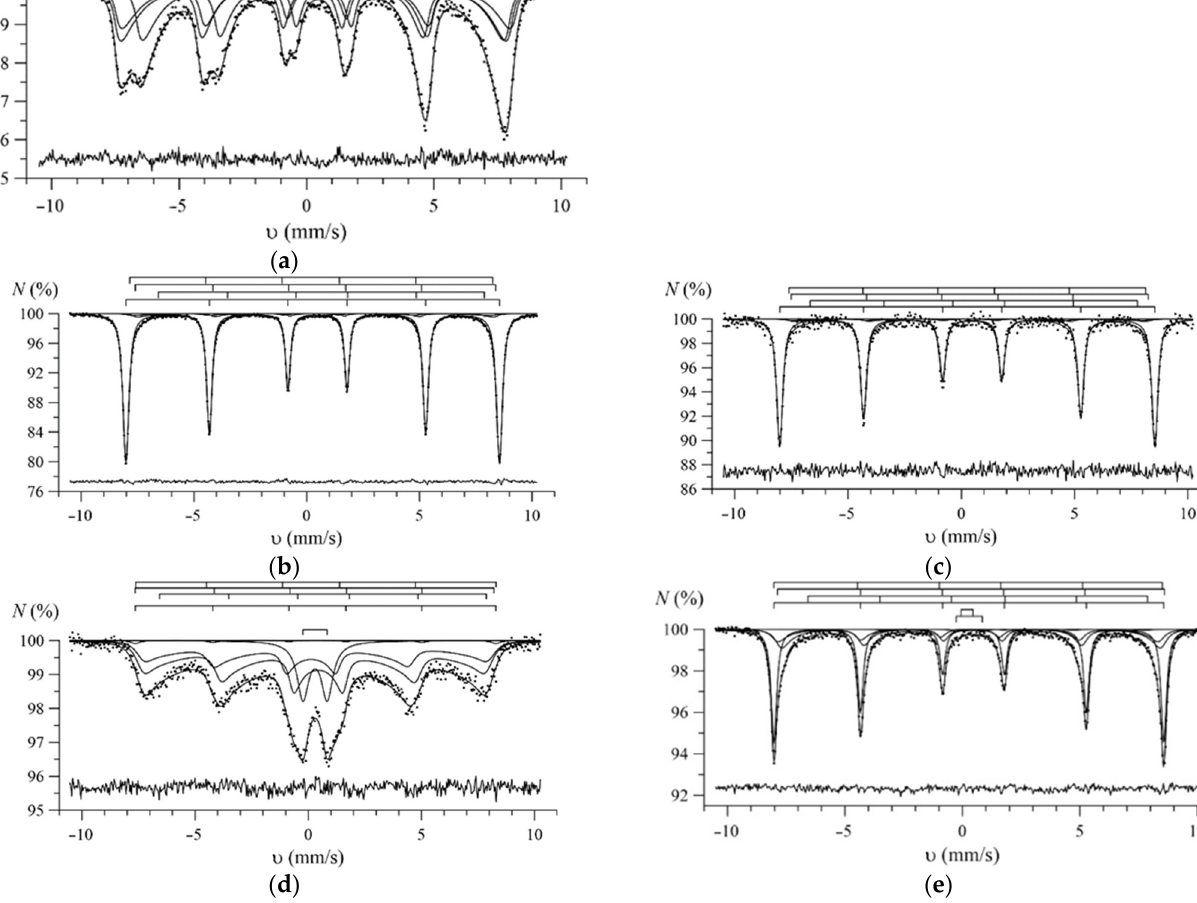
Figure 6. Mössbauer spectra of the studied nanoparticles: ( a ) S0—Fe 3 O 4 (initial), ( b ) S1—Fe 3 O 4 (600 °C), ( c ) S2—Fe 3 O 4 @Au (600 °C), ( d ) S3—Fe 3 O 4 /Gd(NO 3 ) 3 ·6H 2 O (600 °C), ( e ) S4—Fe 3 O 4 /NdFeO 3 (600 °C); above the spectra are dashed diagrams of partial spectra indicating the positions of resonance lines; below the spectra are the difference spectra.